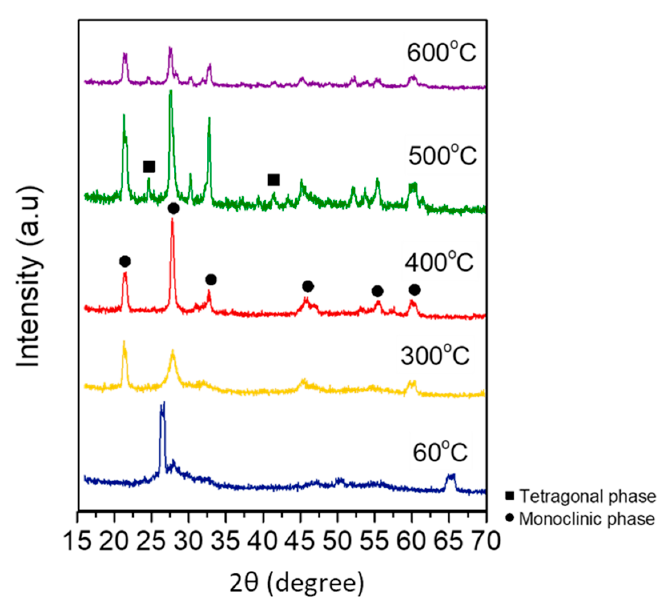
Figure 2. X-ray diffractometer (XRD) analysis for BiVO 4 microspheres under different calcination temperatures.